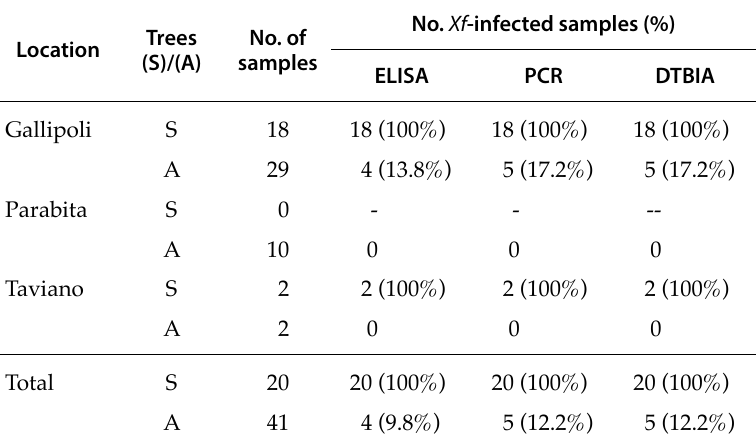
Table 1. Comparative results in the detection of Xylella fastidiosa ( Xf ) in symptomatic (S) and asymptomatic (A) olive trees using DTBIA, ELISA and PCR diagnostic